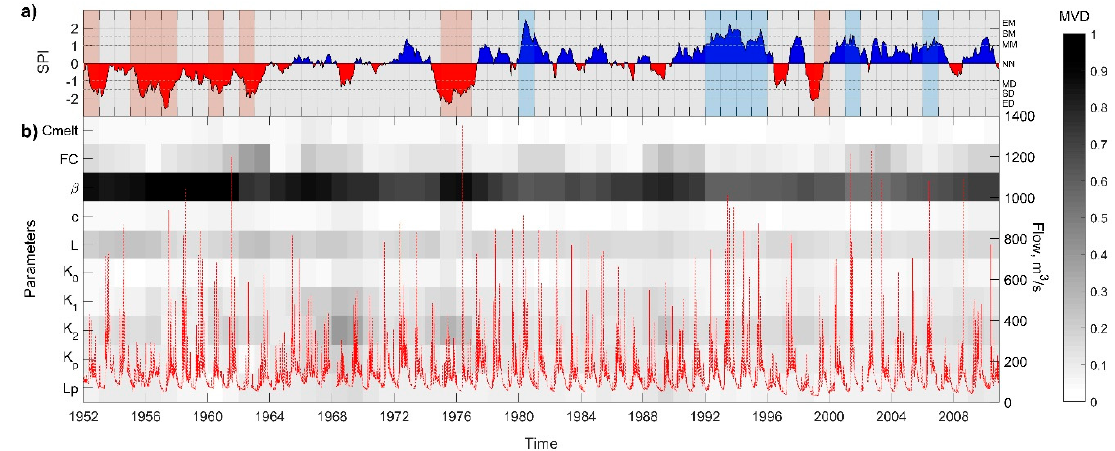
Figure 5. ( a ) Standardized precipitation index (SPI) calculated for the 1952–2010 period. The left vertical axis shows the SPI values and the horizontal axis, time in years. The right vertical axis indicates the categories. The orange areas correspond to dry years, blue to wet years, and gray to normal years. ( b ) Maximum vertical distance (MVD) index for each year (5-year window). The left vertical axis shows the parameters, the horizontal axis, shows the time in years, and the right vertical axis shows the streamflow in m 3 / s as a reference. The dotted red line is the daily mean streamflow series. The MVD values are seen in grayscale.